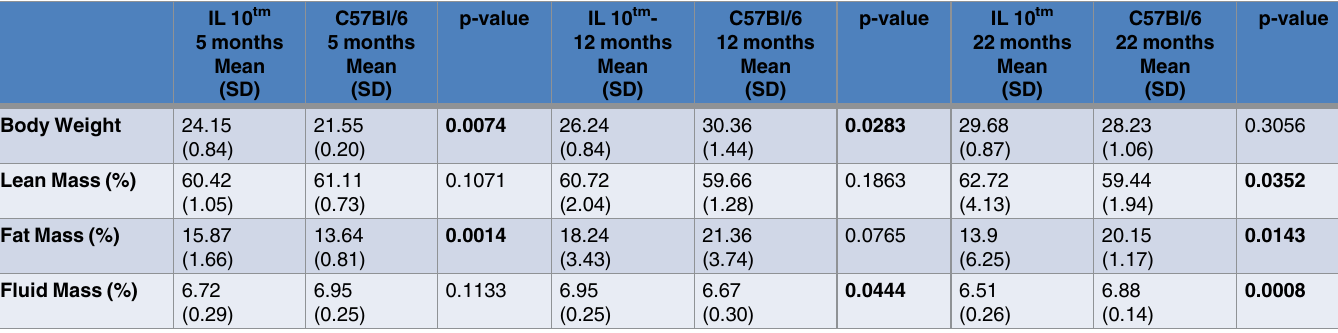
Table 1. NMR-based body